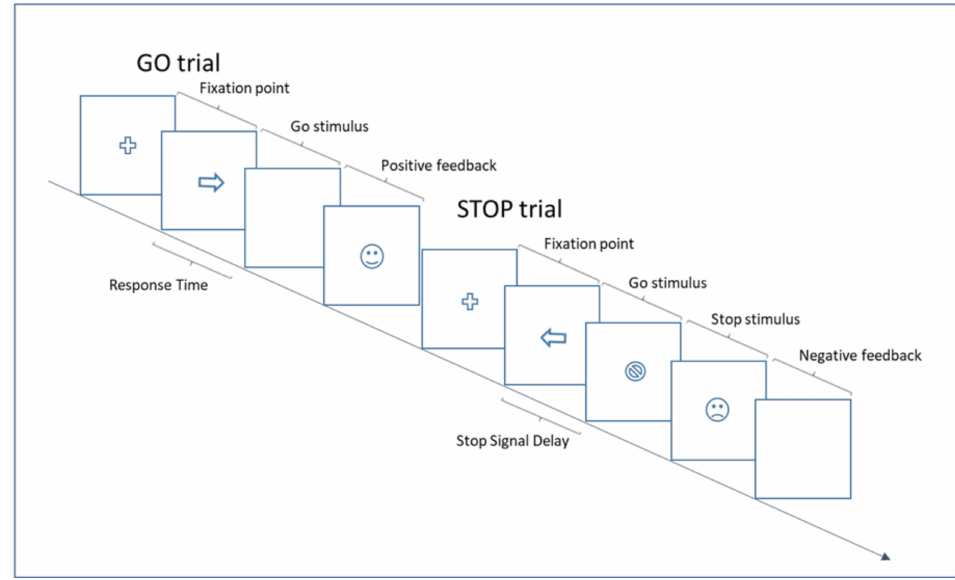
Figure 3. Depiction of the sequence of events in a stop-signal